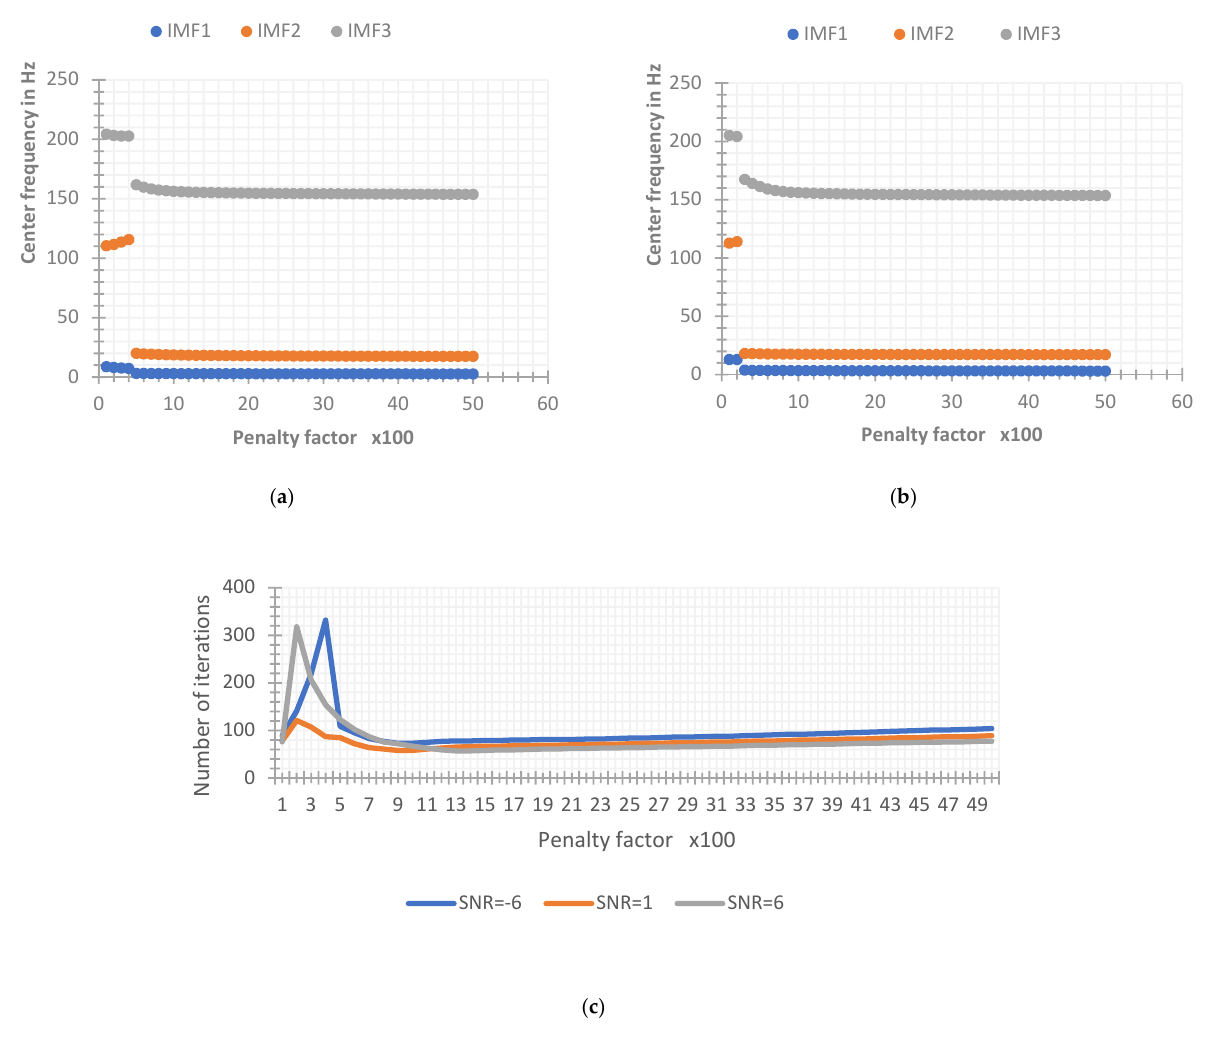
Figure 12. The final convergence frequency and number of iterations of the simulated signal. ( a ) SNR = − 6 dB. ( b ) SNR = 1 dB. ( c ) The number of iterations with different SNRs.